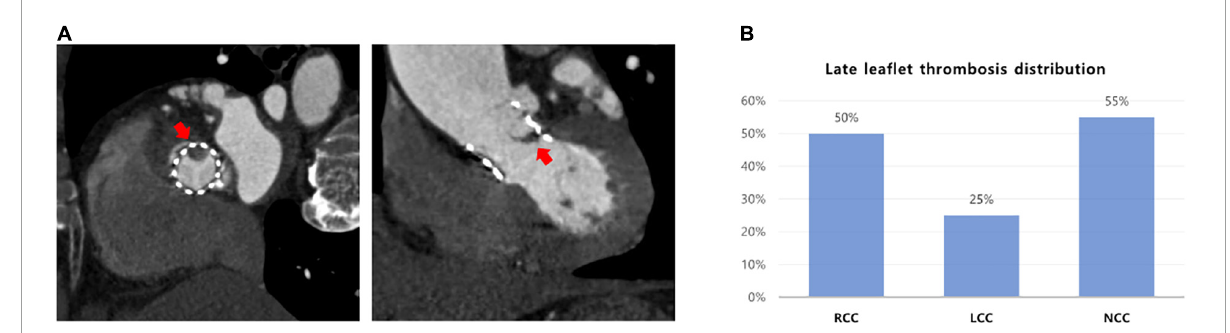
FIGURE1 The distribution of subclinical leaflet thrombosis in TAVR. (A) Evaluation of leaflet thickening and reduced leaflet motion based on MDCT. (B) Leaflet thrombosis distribution in cusps. MDCT, multidetector computed tomography; TAVR, transaortic valve replacement.